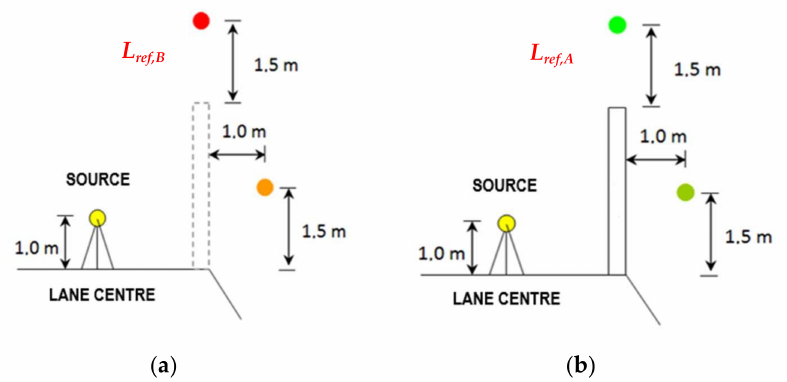
Figure 6. Diagram of the set-up of the measuring points and noise source for the indirect method: ( a ) measurement without a barrier and ( b ) measurement with an installed barrier (distance from the source 5 m).